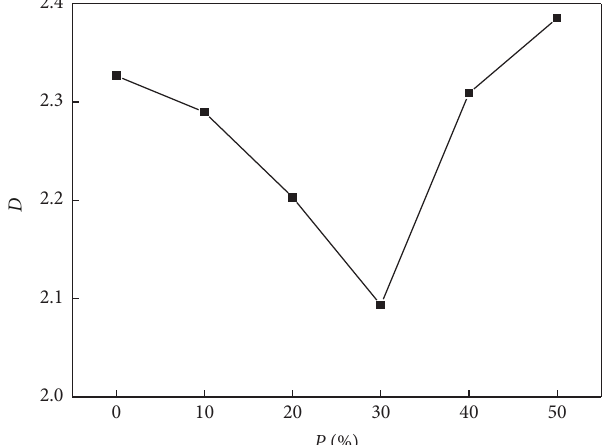
Figure 13: Relationship between the fractal dimension and fy ash